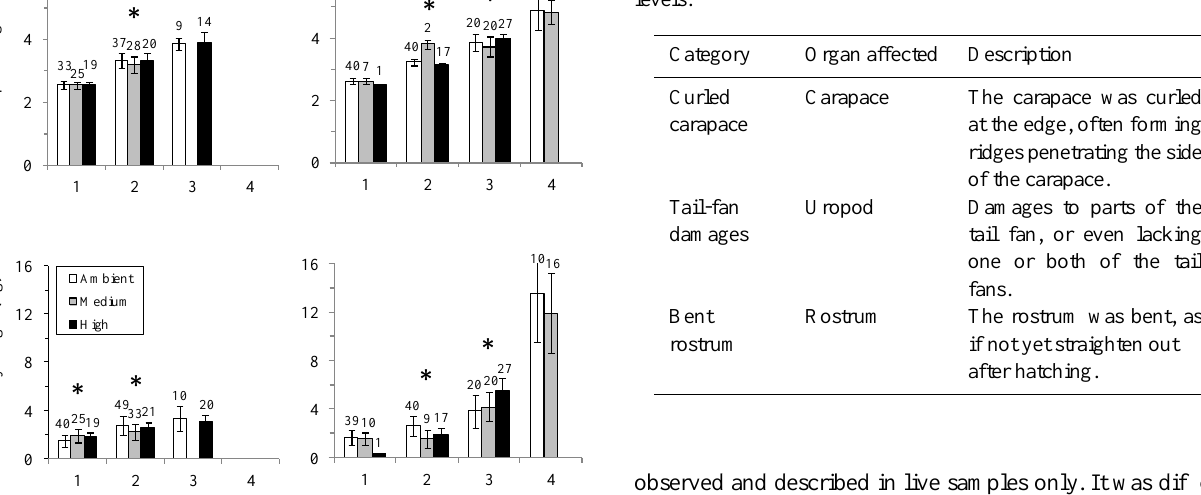
Table 2. Classification of deformities found in larval stages 1 to 4 in European lobster ( Homarus gammarus ) exposed to elevated p CO 2